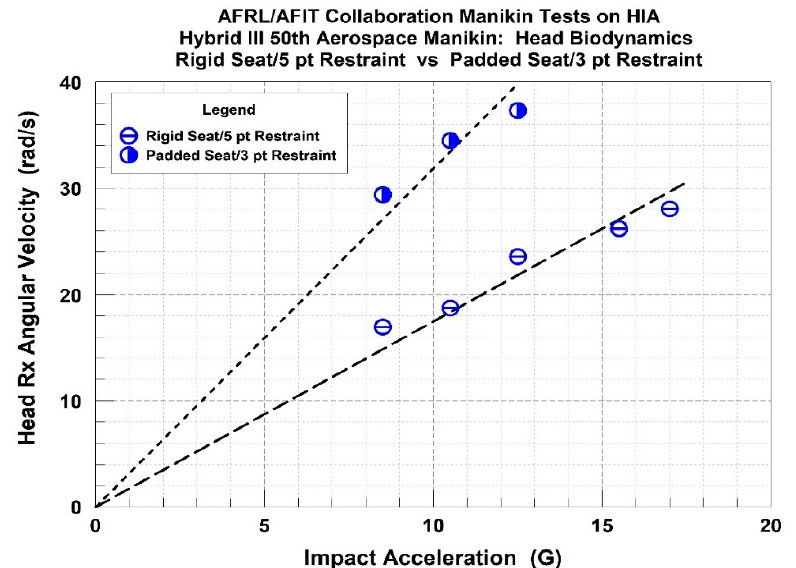
Figure 9. Comparison of head Rx angular velocity with different seats. The plot shows a comparison of the head angular velocity around the x -axis from impacts with the rigid seat configuration compared to the head angular velocity around the x -axis from impacts with padded seat configuration. The head velocities with the padded seat are shown to be greater than with the rigid seat at all comparable impact accelerations.